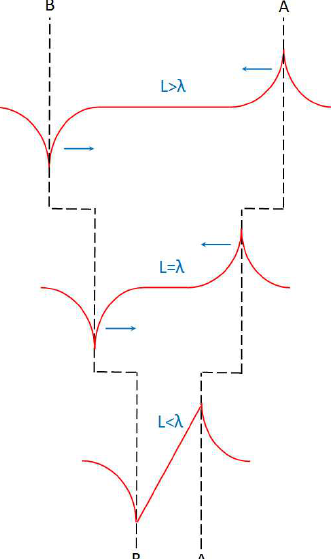
Figure 19. Diagram of LPV responding to laser position (see red curves) with different contacts’